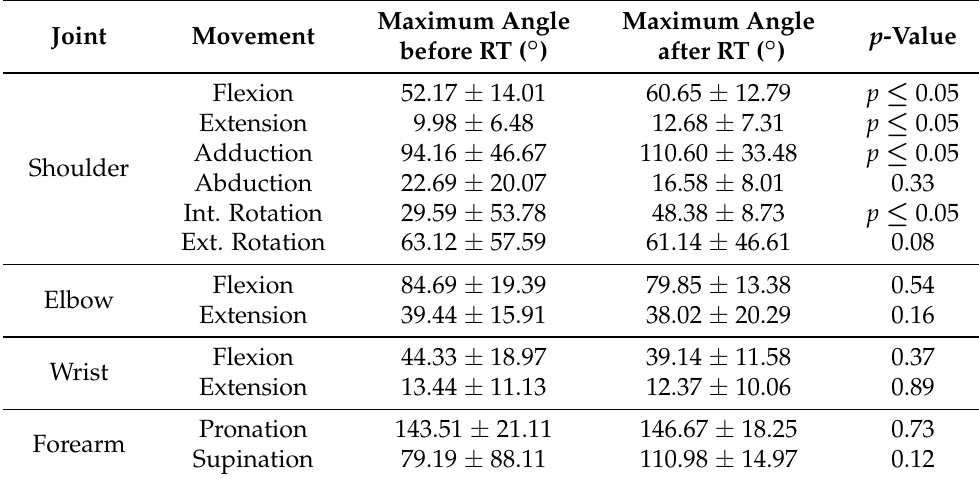
Table 2. Maximum angles obtained for the paretic limb in the Maximum Forward Reach Test before and after the rehabilitation